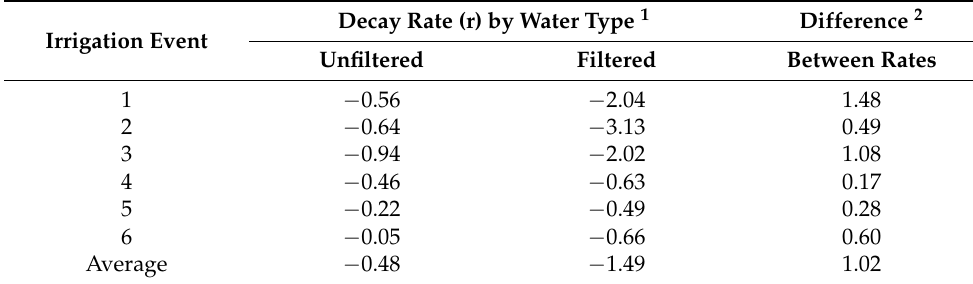
Figure 2. Levels of E. coli TVS 353 (lnMPN/mL) in filtered (light gray) and unfiltered (dark gray) irrigation water. Samples were collected the day of filtration-irrigation and 1, 3, 5, 7, and 10 days afterwards. When bacterial enumeration resulted in levels below the detection limit, values of 1.54 lnMPN/mL were used for analyses and display within the figure. Table 2. The average decay (lnMPN/day) of E. coli TVS 353 in unfiltered and filtered irrigation water for each irrigation event ( n = 6) and the difference observed in the bacterial decay between each water